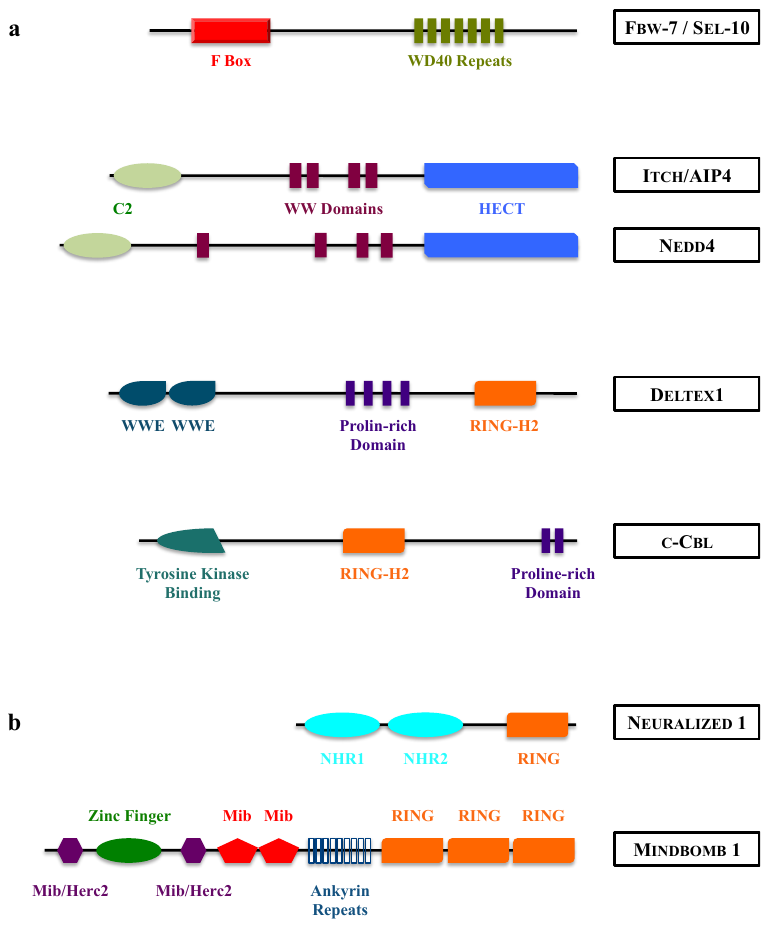
Figure 4. Structure of mammalian E3 ubiquitin ligases acting on Notch receptor ( a ) or DSL ligands ( b ). HECT: Homologous to E6-AP Carboxy Terminus; RING: